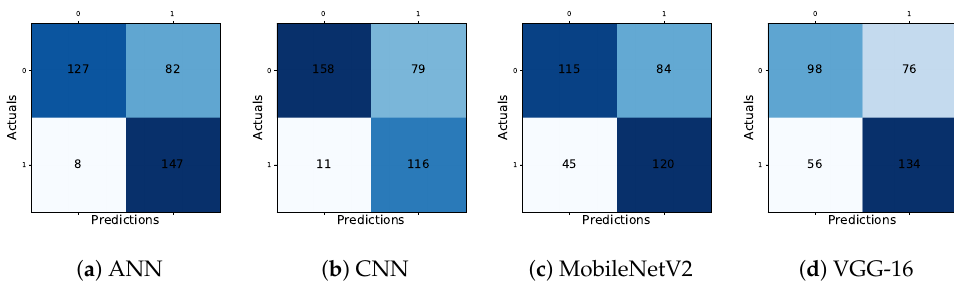
Figure 8. Confusion matrices for pest